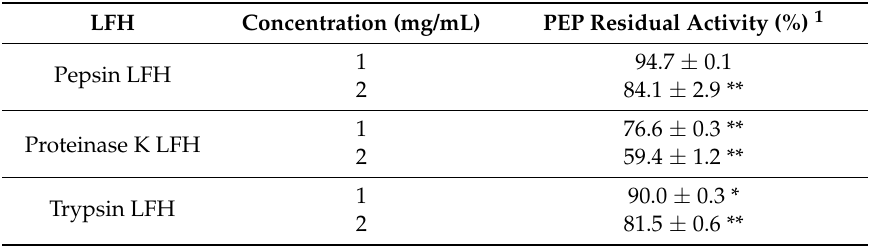
Table 1. Effects of lactoferrin hydrolysates (LFH) on prolyl endopeptidase (PEP) activity.